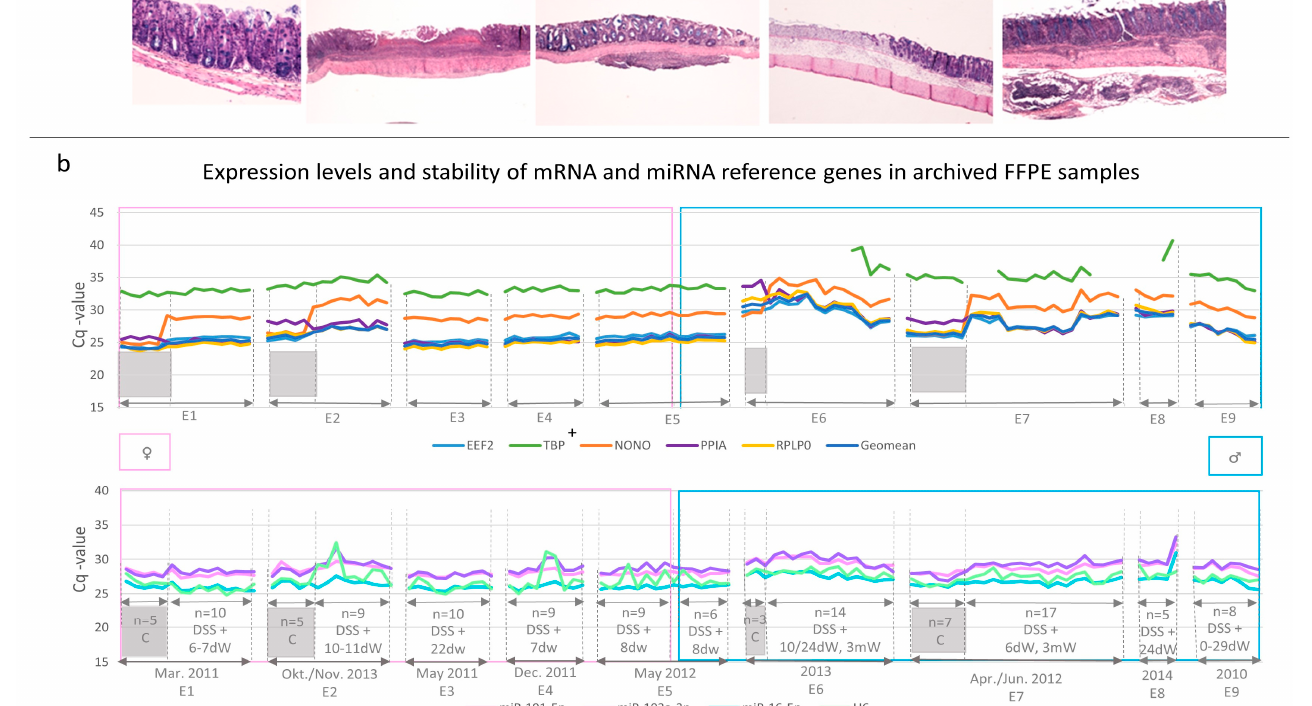
Figure 1. Representative histological pictures and expression levels of candidate reference genes in archived FFPE colon samples of control and DSS treated C57BL6/JOlaHsd mice. ( a ) Representative pictures of archived FFPE colon samples (Kreyberg-Jareg staining) show colon wall histologically evaluated as normal or altered (mild/moderate/severe inflammation, erosion, inflammation limited to the mucosa or extending into deeper layers of colon wall). ( b ) Expression and stability of all candidate reference genes in archived FFPE colon samples from 9 DSS experiments (E1–E9) conducted in year from 2010 to 2014 (n = 117). Graph shows Cq-values of reference genes (y-axis) in all archived FFPE samples shown as (x-axis) number of FFPE samples (n) selected from each experiment (E1-E9), together with the information about DSS treatment (i.e., DSS and control groups separated by sex: females (pink frame) and males (blue frame)) and duration of inflammation (dW, mW). Legend: E1-E9, experiment number; C, control group; DSS, dextran sodium sulphate treatment; dW, days of water; mW, months of water; n, number FFPE samples represent the number of animals; TBP+, 16 of 117 FFPE samples were undetermined for TBP, 2 from the control and 14 from the DSS group, all undetermined FFPE samples were males.